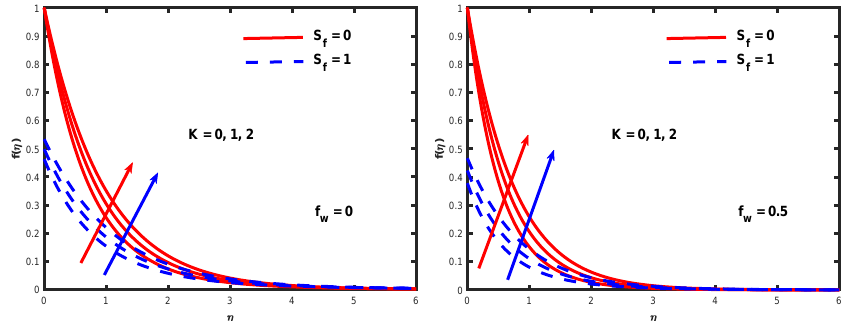
dynamic viscosity. The larger value of K means smaller dynamic viscosity µ and hence the speed of flow becomes faster.